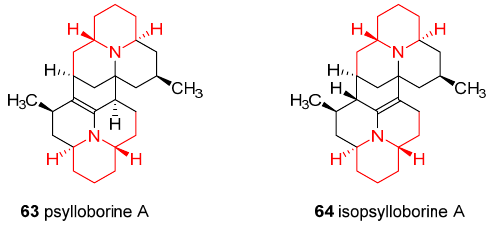
Figure 6. Structures of the alkaloids psylloborine A and isopsylloborine A.